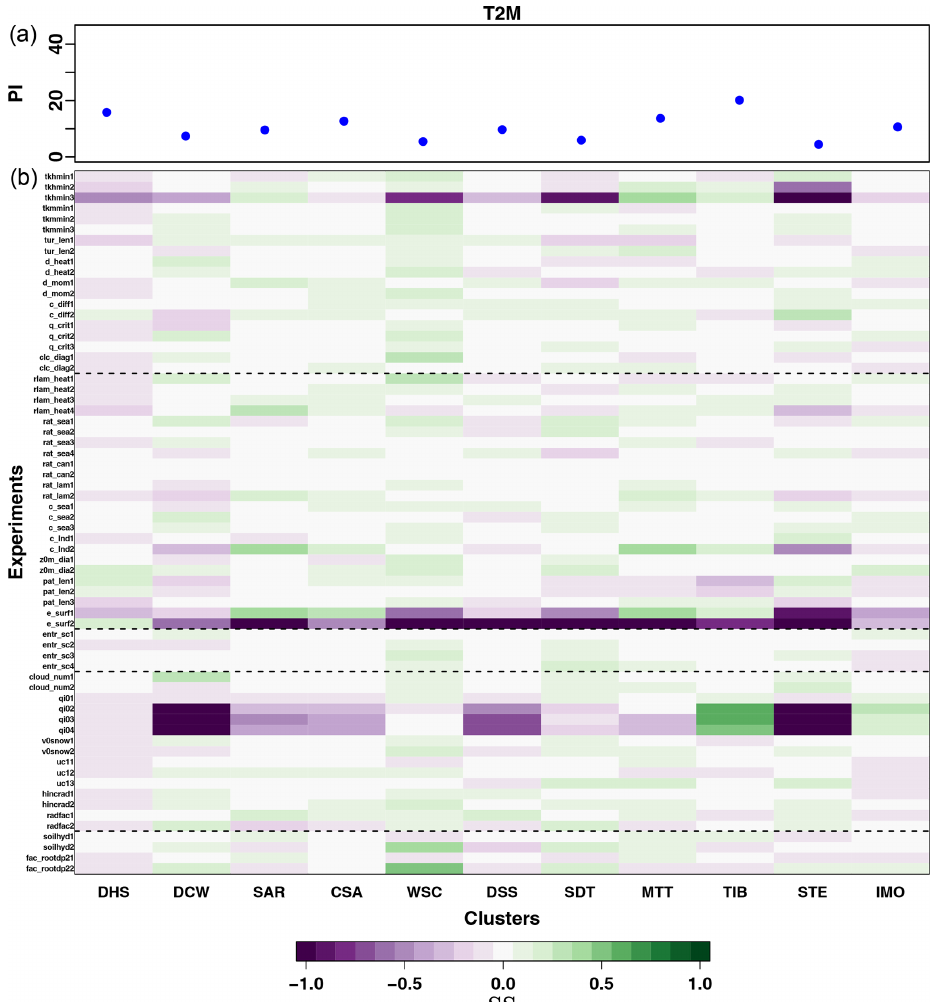
Figure 5. (a) PI calculated for near-surface temperature (T2M) for the reference experiment with default parameter values, over each of the 11 Central Asia subregions. (b) Changes in the SS of each performed experiment, calculated with respect to the default simulation, for near-surface temperature (T2M): green (violet) values indicate a better (worse) agreement with observations with respect to the default simulation. The experiments for each parameter are enumerated in an increasing order, according to its tested values, from the lowest to the highest. The different simulations are additionally grouped depending on the main physical scheme the tested parameter is characteristic of, in the same way as they are in Table 2.